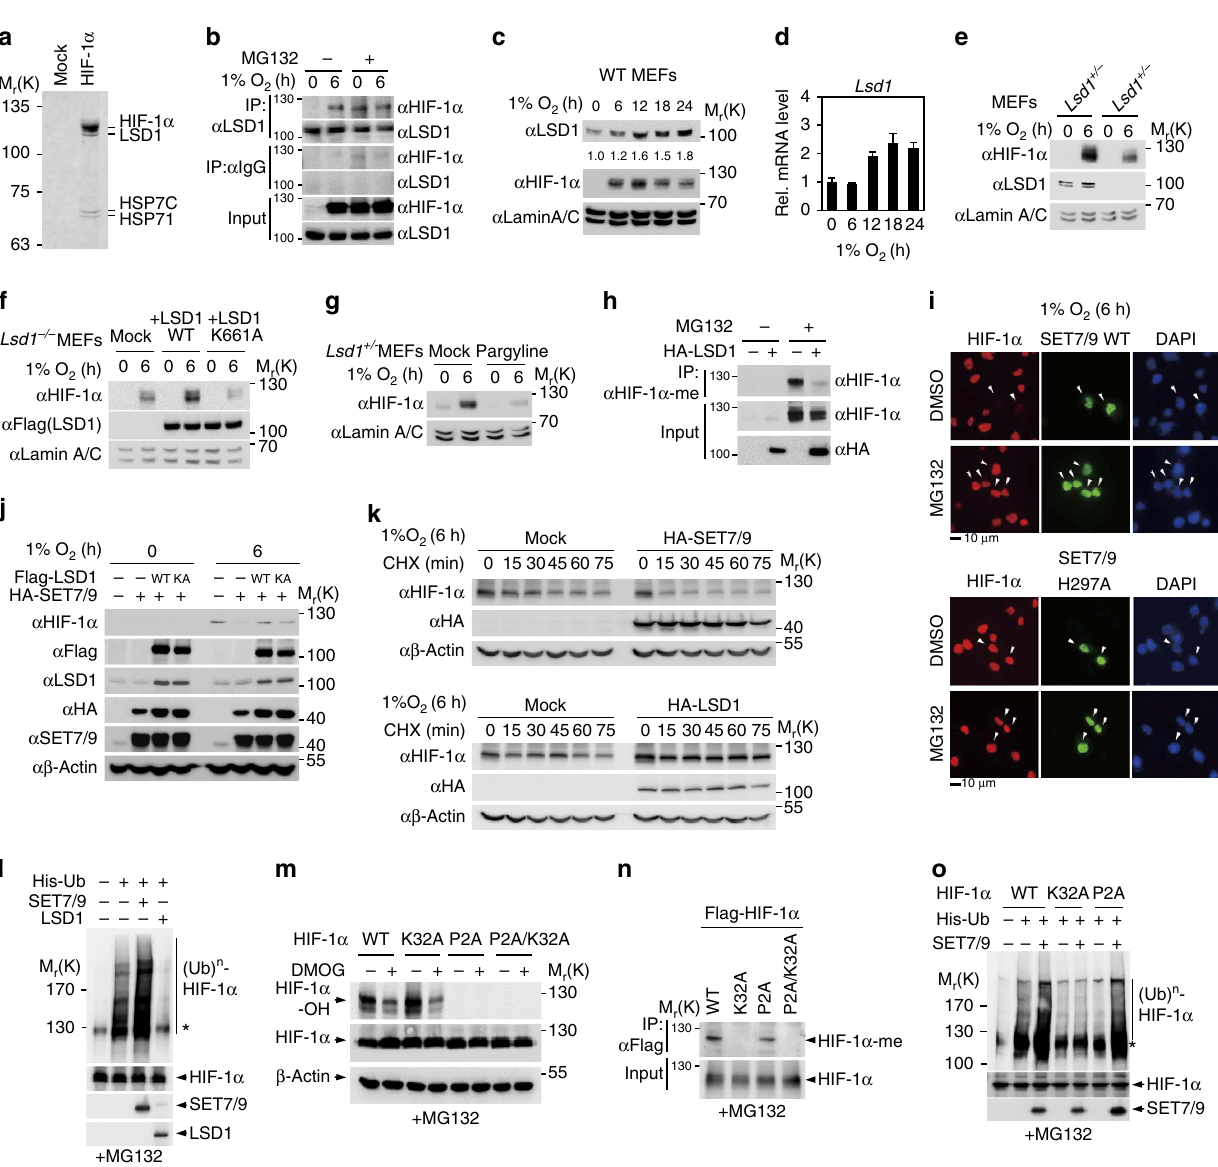
amino acids showed direct binding to LSD1 (Supplementary Fig. 1d). Co-immunoprecipitation assay revealed that HIF-1 a and LSD1 showed comparable binding in the absence or presence of SET7/9 (Supplementary Fig. 1e), confirming that the binding